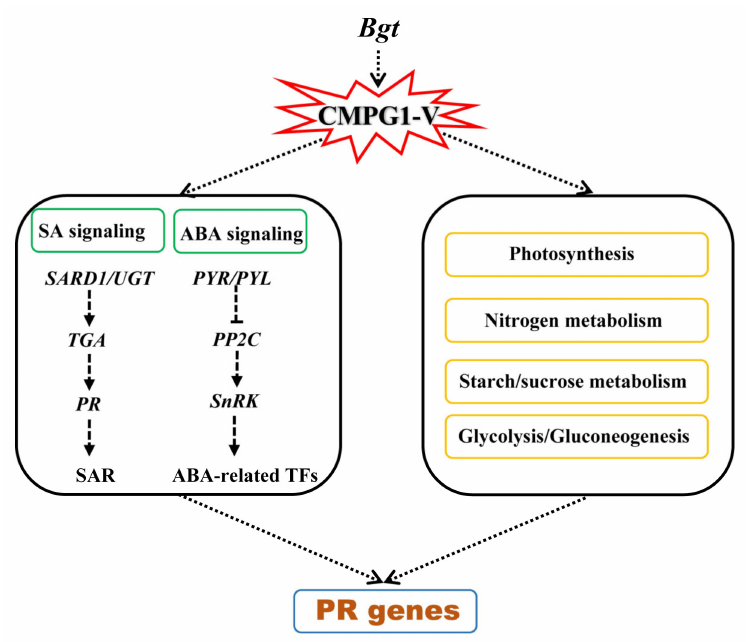
Figure 9. Proposed model for the molecular mechanism of powdery mildew resistance mediated by CMPG1-V